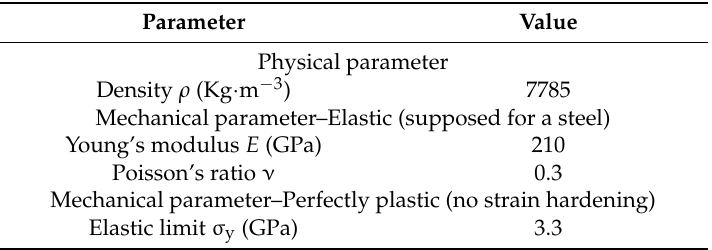
Table 2. Material parameters used in the numerical